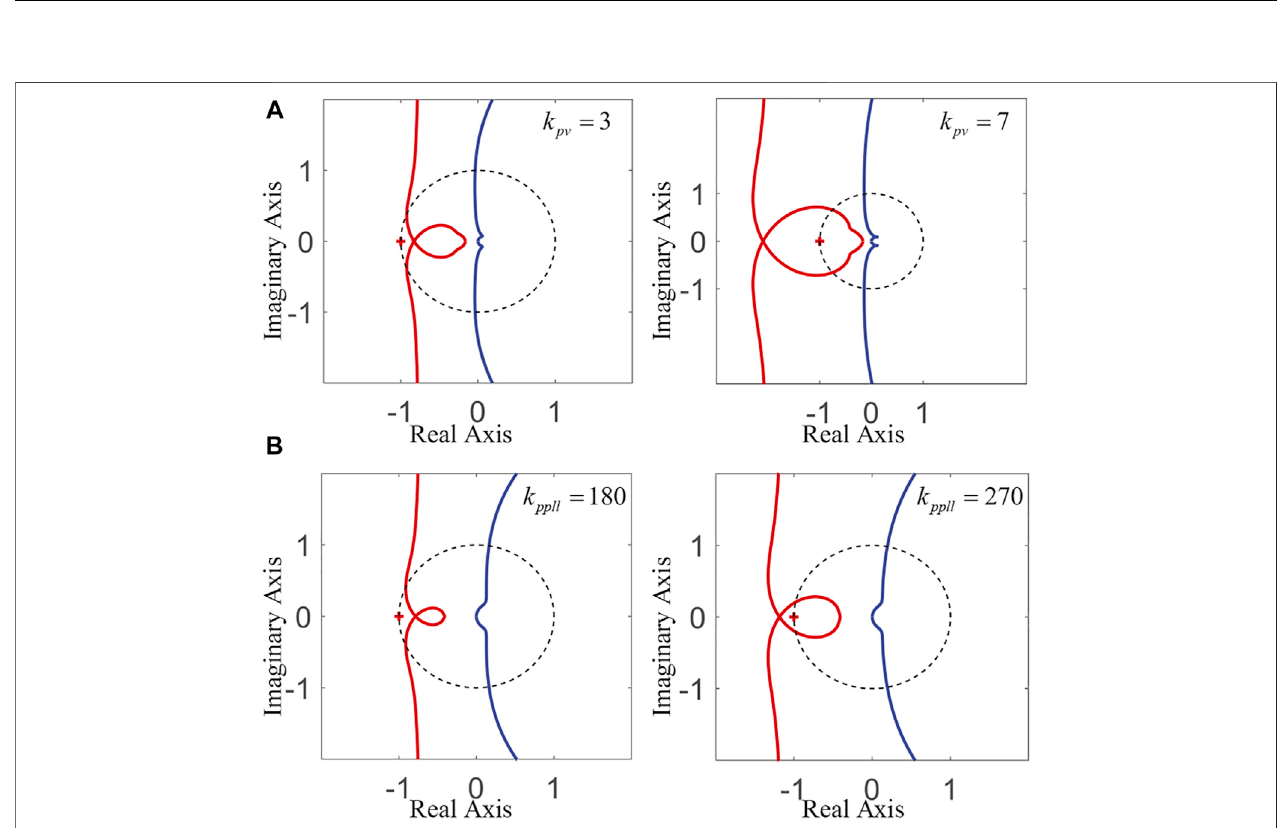
FIGURE 8 | Small signal model of the grid-connected inverter with PLL, ACC, and DVC.